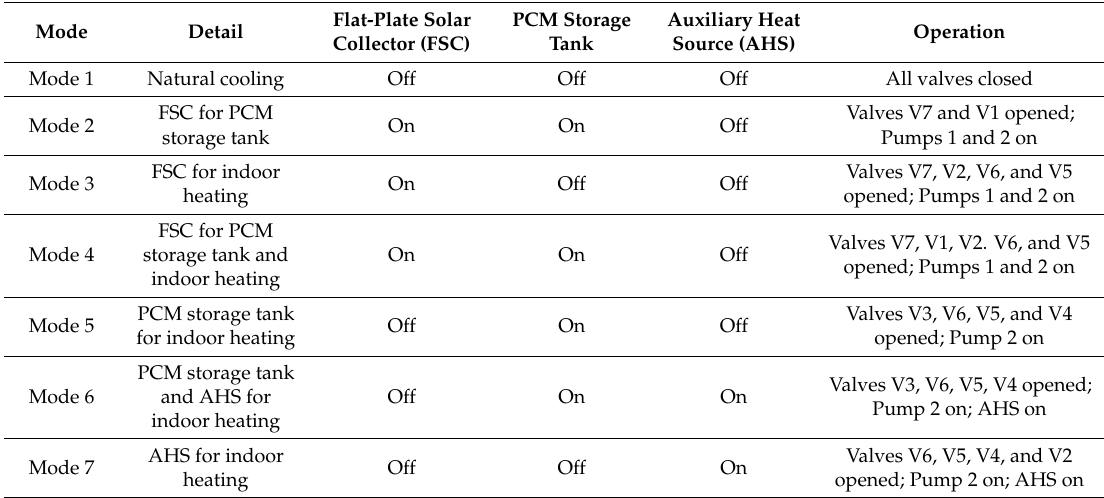
Table 1. Operating modes and control parameters of the